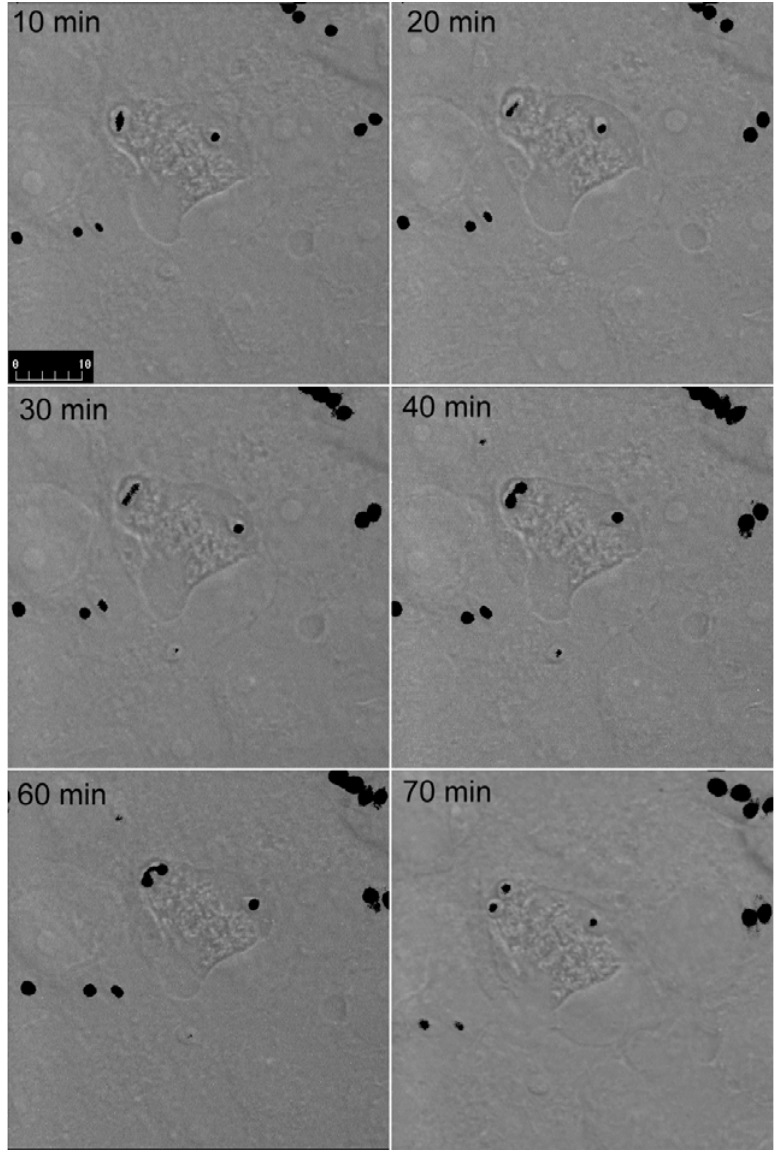
Fig. 7 – T. cruzi amastigotes divide within C. burnetti vacuole. Metacyclic trypomastigotes invade Vero cells colonized with C. burnetti and after 48h the resulting amastigotes (here labeled with Histone H2-GFP, in black, over grey DIC background images) are seen dividing. Bar in µ m.